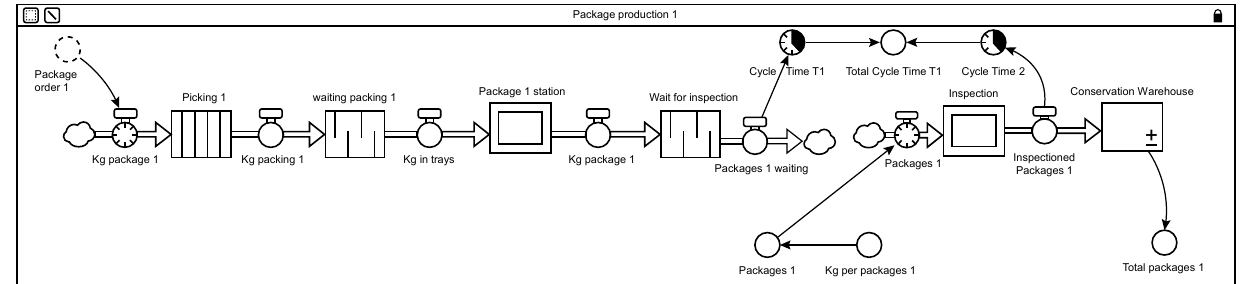
Figure 6. Forrester diagram of the packaging process.